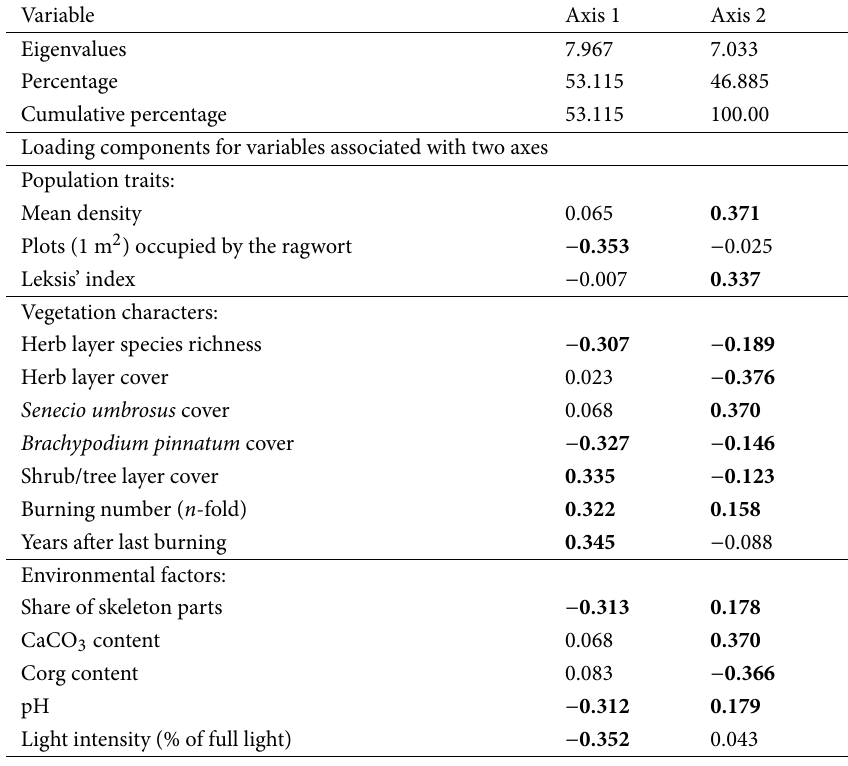
Table 5 Results of principal component analysis (PCA) based on Senecio umbrosus population traits, vegetation characters, and habitat factors; population and vegetation